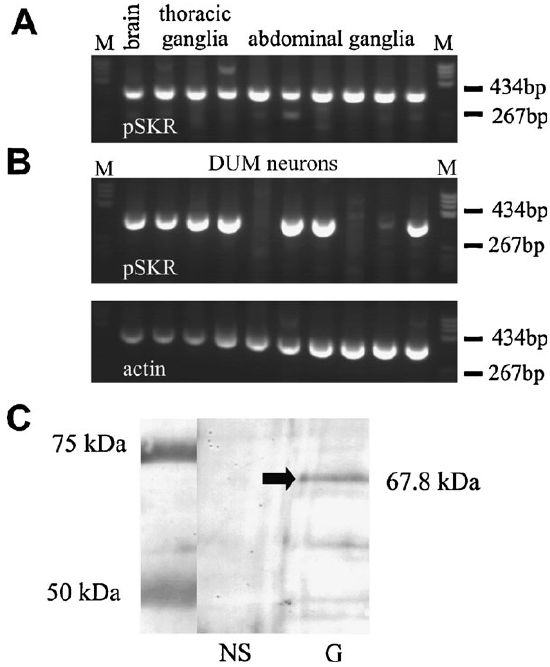
Figure 4. RT-PCR and Western blot analysis of PSKR expression . ( A ) Nested RT-PCR analysis of the PSKR expression in brain and ganglia. A 362bp PCR product was amplified in all neuronal samples tested. ( B ) Single- cell RT-PCR analysis of isolated DUM neurons. In 7 out of 10 DUM neurons a PSKR-specific band was found (upper panel). As an endogenous expression control an actin-specific RT-PCR was used (lower panel). M, marker pBR322 DNA BsuRI digested (two marker bands are indicated). ( C ) Western blot analysis of PSKR expression in nervous system (NS) and gut (G). A (cid:2) 68-kDa band was found in gut only but not in the nervous system. Protein marker bands are indicated in the left lane .